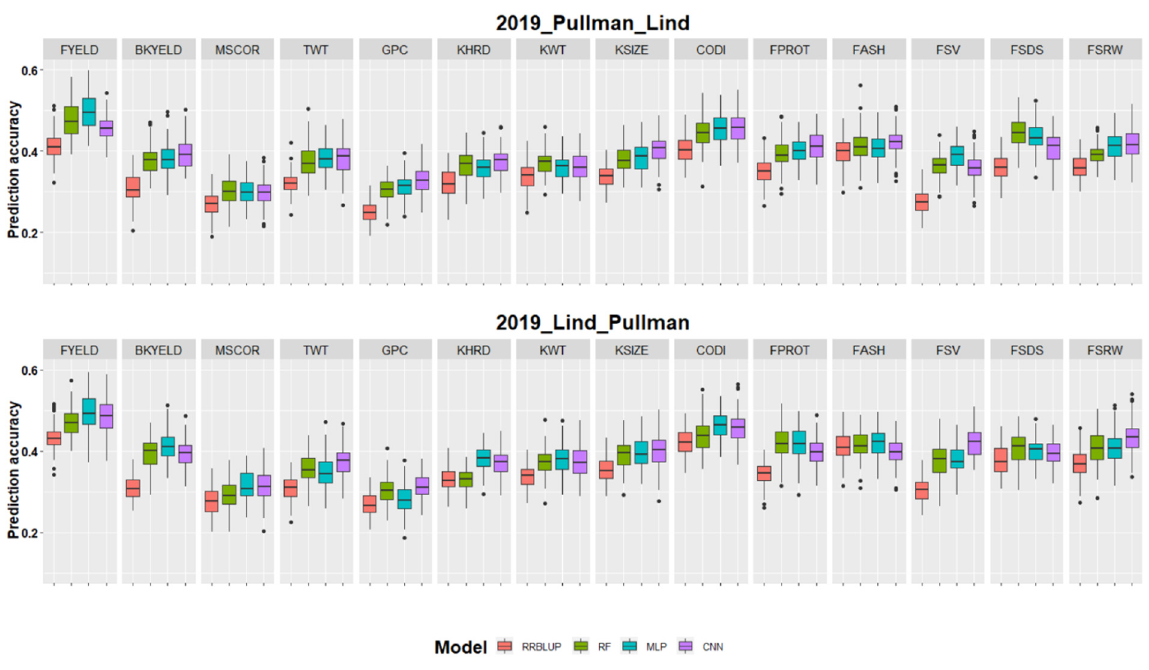
Figure 5. Genomic selection across environment prediction accuracies for fourteen end-use quality traits evaluated with four different models. 2019_Pullan_Lind denotes the scenario where 2019_Pullman was predicted using datasets from Lind as training set and vice versa for 2019_Lind_Pullman. Results are provided separately for both locations and each trait is separated with facets. Table 4. Genomic selection across environment prediction accuracies for fourteen end-use quality traits evaluated with four different models. 2019_Pullan_Lind denotes the scenario where 2019_Pullman was predicted using datasets from Lind as the training set and vice versa for 2019_Lind_Pullan. The highest accuracy for each trait is bolded under different model scenarios.